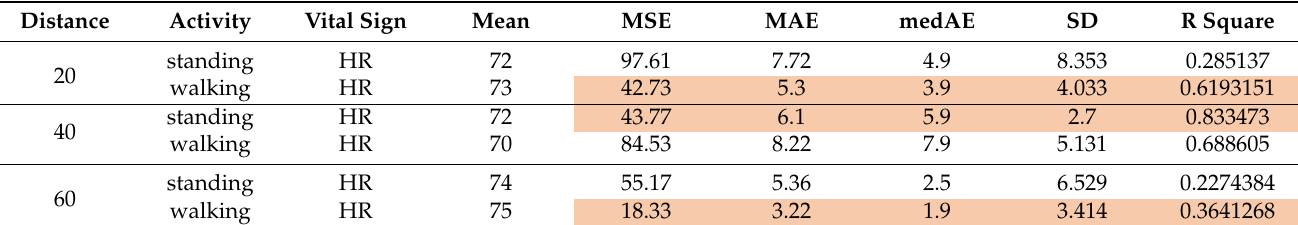
Table 6. Performance analysis of heart rate with respect to Omron